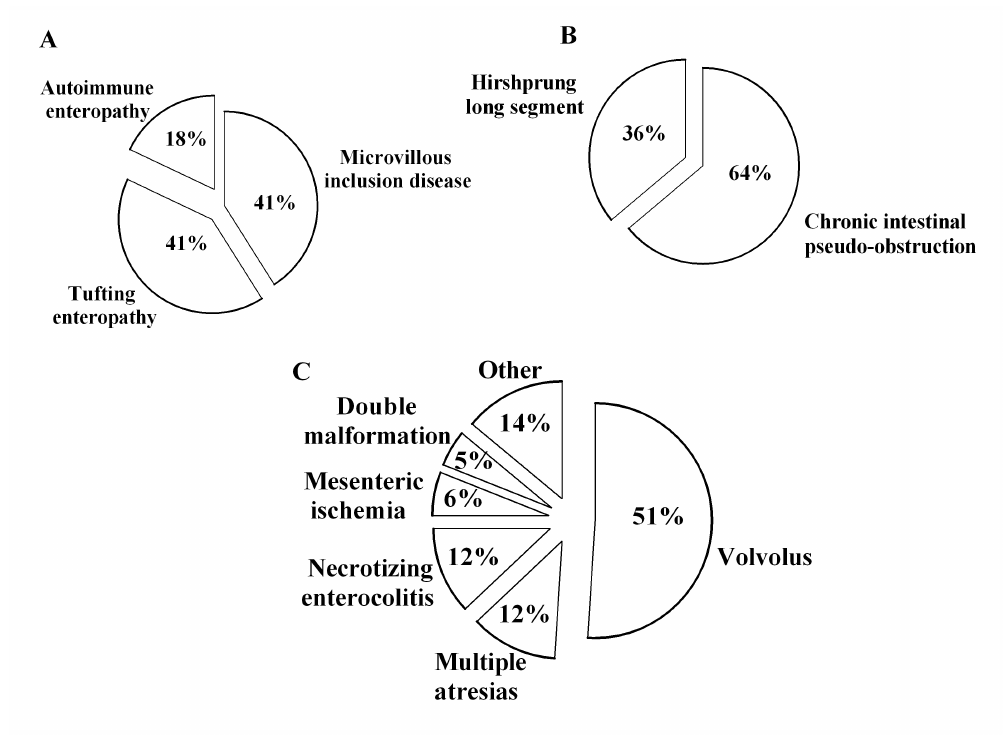
Figure 5. Indications for home parenteral nutrition programs in primary digestive diseases. ( A ) Etiology of mucosal diseases. ( B ) Etiology of motility disorders. ( C ) Etiology of short bowel